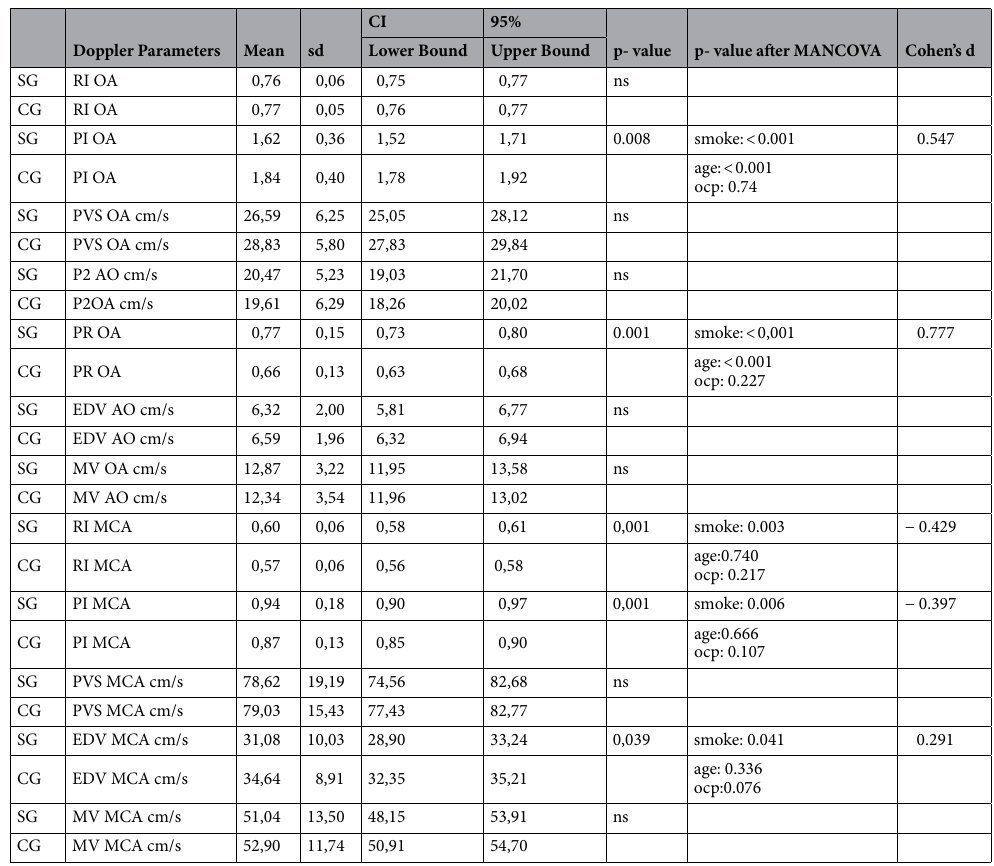
Table 3. Comparison between means and standard deviation of Doppler indexes in the ophthalmic and middle cerebral arteries of smoking and non-smoking women. OA Ophthalmic Artery, MCA Middle Cerebral Artery, MV mean velocity, RI Resistance Index, PI Pulsatility Index, PVS Peak of Velocity Systolic, P2 second peak of velocity, PR peak ratio, EDV End Diastolic Velocity, SG study group, CG control group, cm/s centimeter/second, ocp oral contraceptive, sd standard deviation, ns non significant.